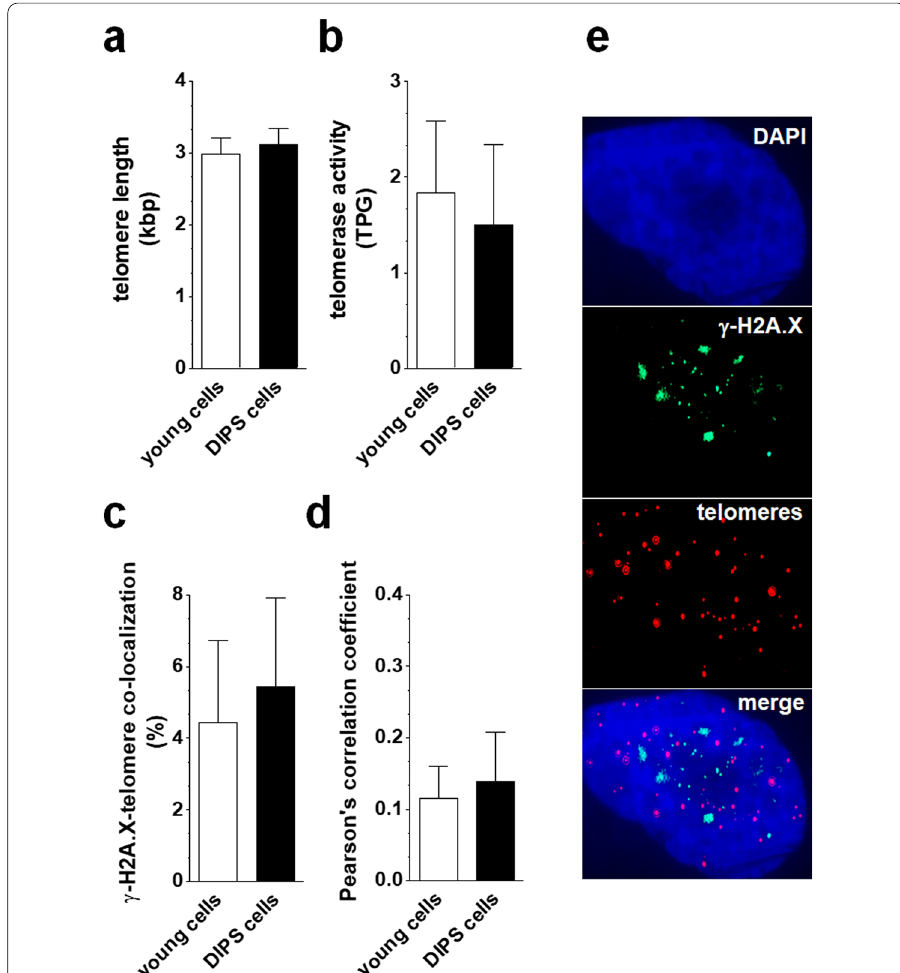
Fig. 3 Assessment of the role of telomeres in DIPS of HGSOCs. Changes in telomere length ( a ) and telomerase activity ( b ) during DIPS were analyzed using RT‑qPCR. Analysis of the colocalization of histone γ‑H2A.X foci (green dots) with telomeric ends (red dots) in young and DIPS cells ( c , e ). Determination of Pearson’s correlation coefficient for the colocalization measurements. The image analysis includes identifying areas where green color overlaps with red, yielding yellow. At these locations, DNA damage is present within the telomeres, indicating a telomere‑dependent mechanism of senescence. When the two colors do not overlap, i.e., the Pearson’s correlation coefficient is low (far below 1), the DNA damage is located in non‑specific regions of the genome, suggesting that cells senesce in a telomere‑independent manner ( d ). The results derive from 6–8 experiments with HGSOCs obtained from different donors. The results are presented as the means SEM. TPG total product ±